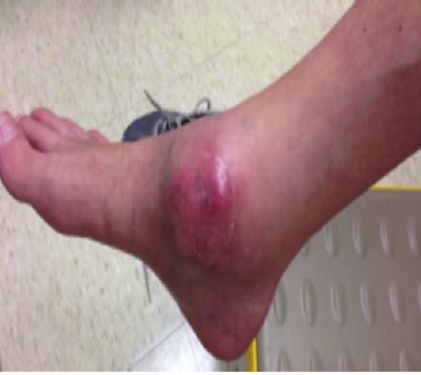
Figure 2: Swelling over the right ankle.